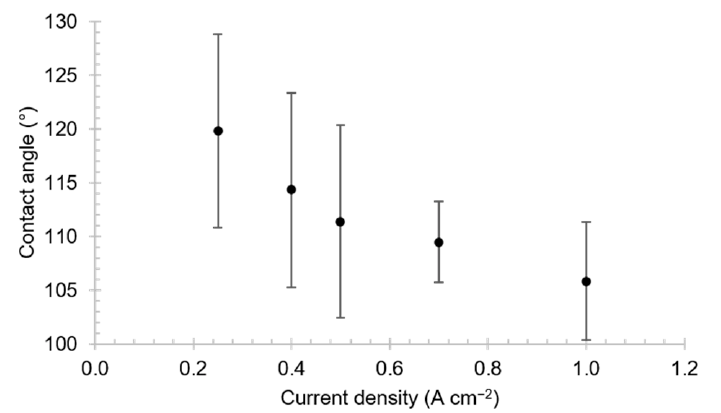
Figure 12. The change of contact angle of the bubble at the horizontal anode during electrolysis at different current densities